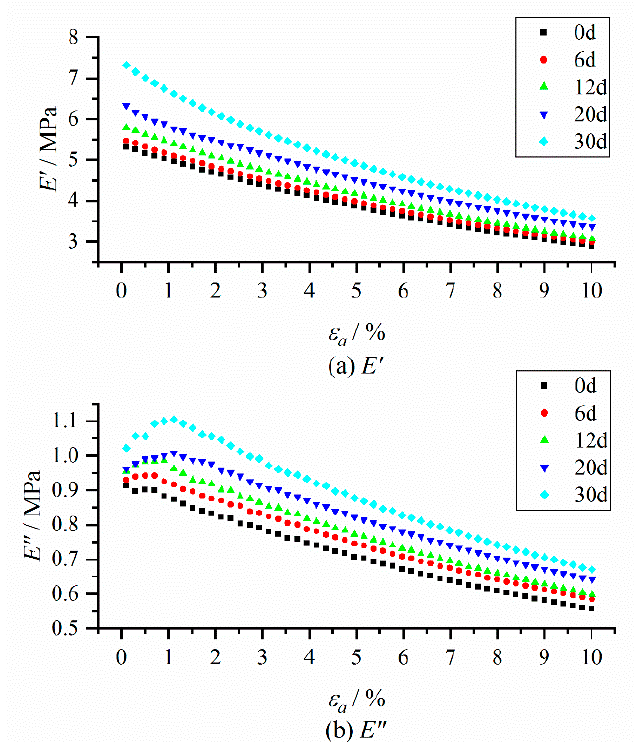
Figure 8. Changing curves of storage modulus and loss modulus with the dynamic strain amplitude at different aging times. ( a ) Storage modulus E ' ; ( b ) Loss modulus E” .